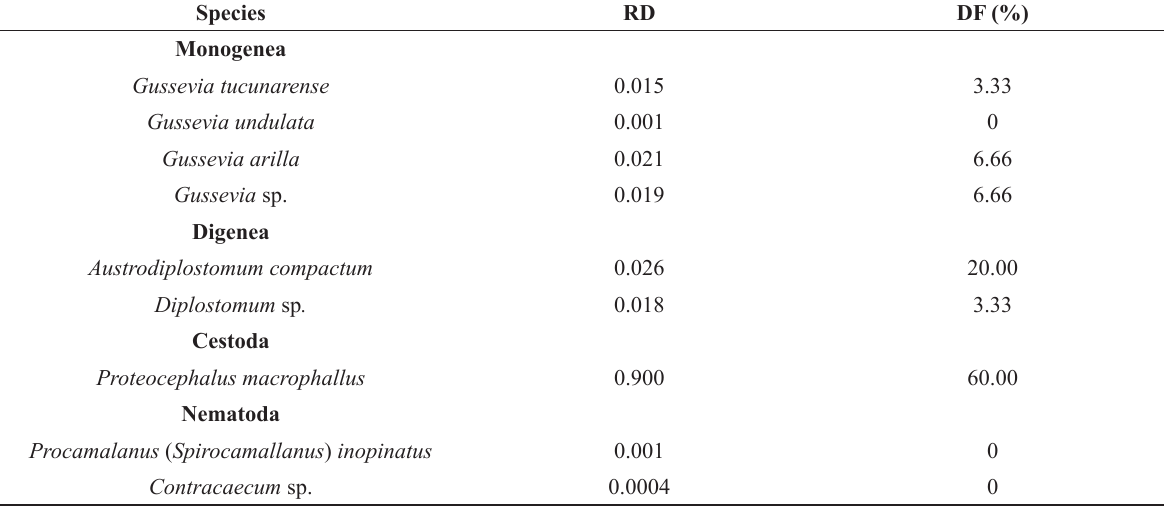
Dominance indices for each component of the Cichla ocellaris Bloch & Schneider, 1801 parasitic infracommunities collected in the Jacaré-Pepira River, State of São Paulo, Brazil (relative dominance RD, DF dominance frequency).